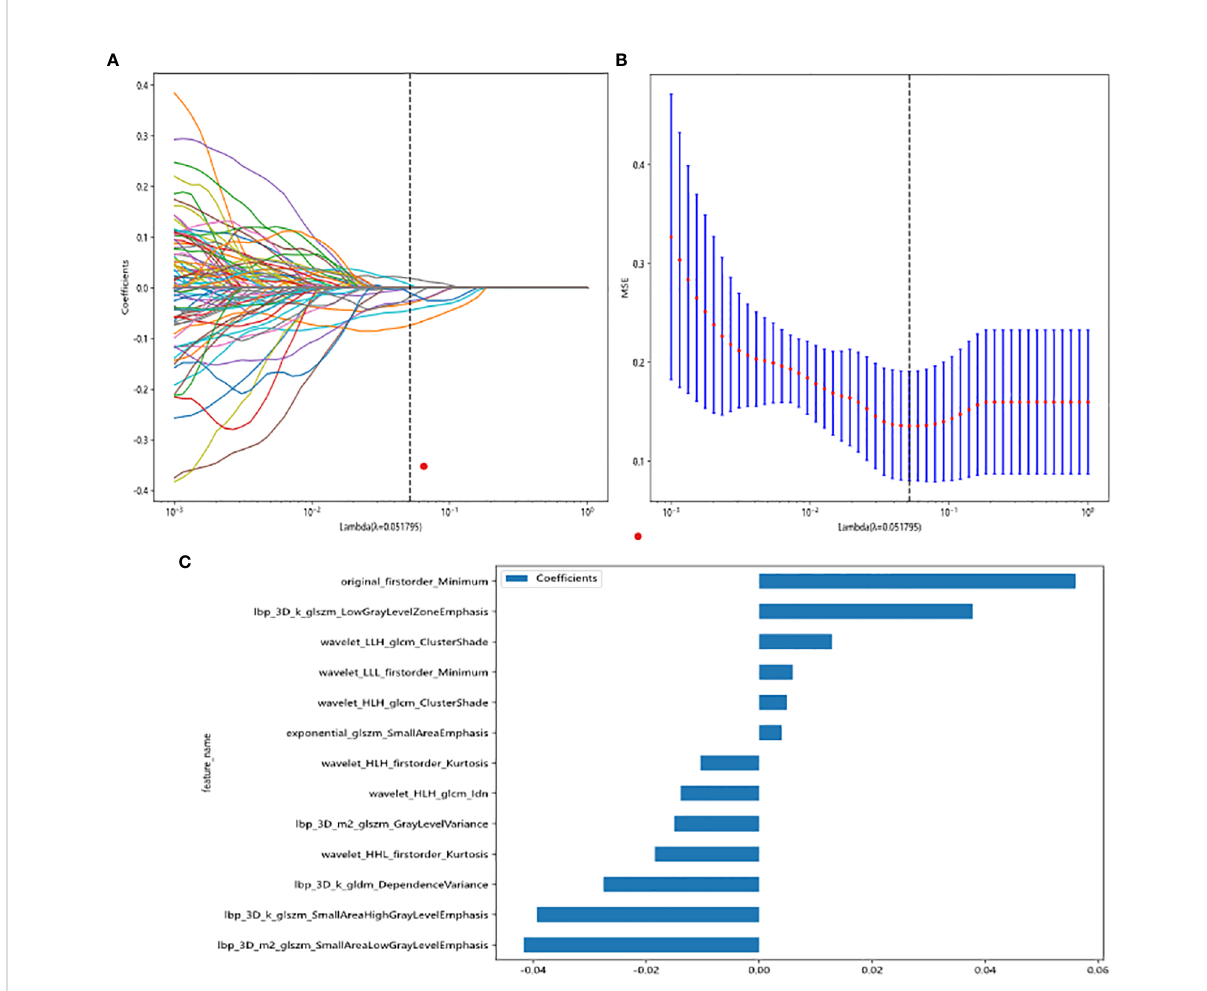
FIGURE 3 Radiomic feature selection based on LASSO algorithm and Rad score establishment. (A, B) Ten-fold cross-validated coef fi cients and 10-fold cross-validated MSE. (C) The histogram of the Rad score based on the selected